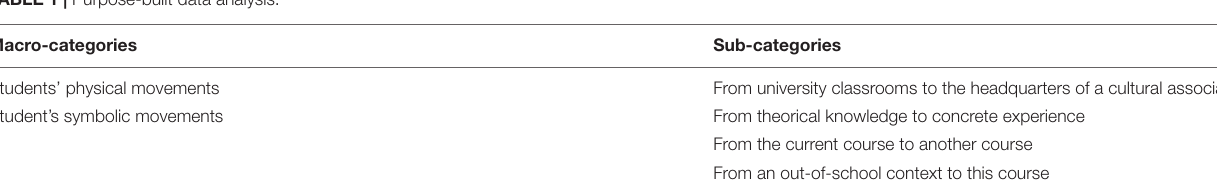
TABLE 1 | Purpose-built data analysis.